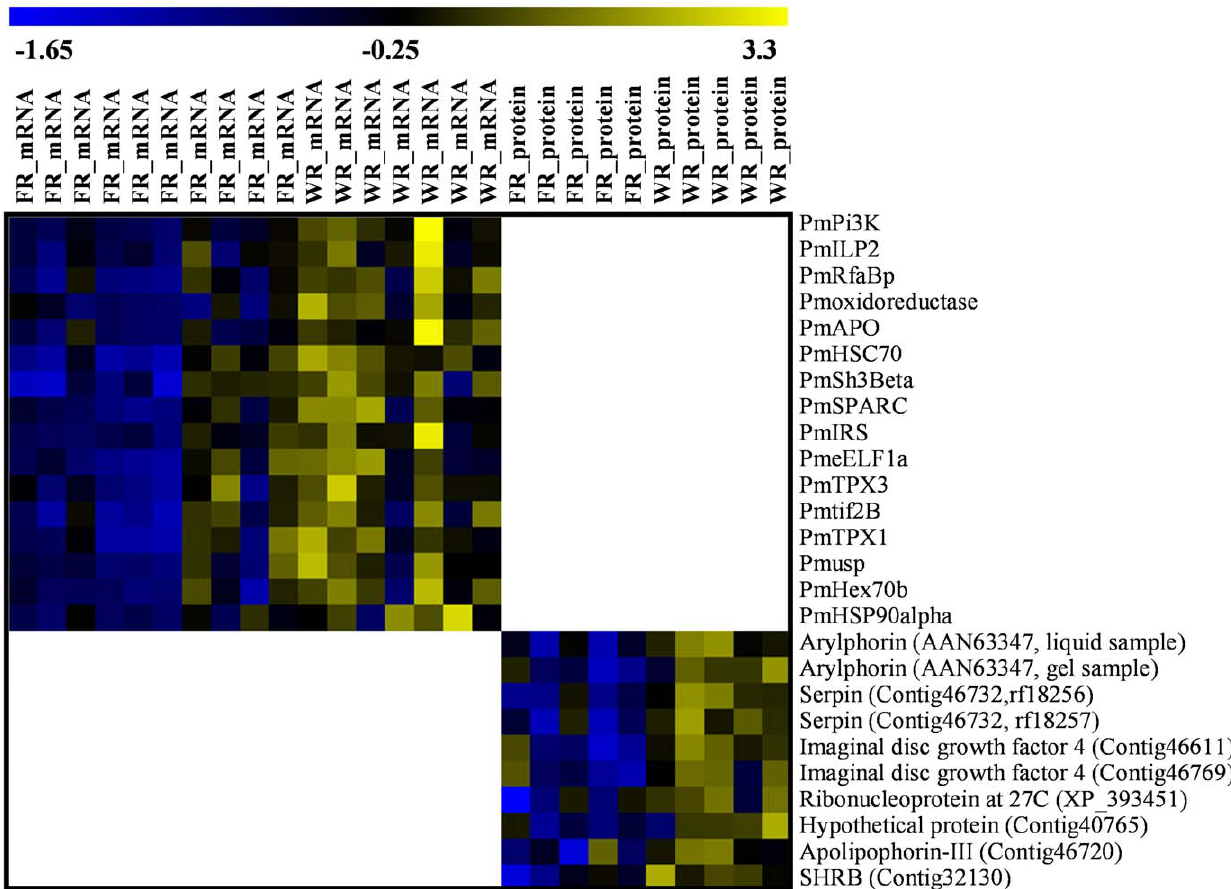
Figure 1. Heat map visualization of relative expression of sixteen genes and nine peptides. Sixteen genes (upper) and 9 peptides (lower) significantly differentially expressed in foundress-reared (FR; putative worker-destined) vs. worker-reared (WR; putative gyne-destined) P. metricus fifth-instar larvae. Bar at top gives color scale of relative expression from the mean expression: downregulation = blue; upregulation = yellow. Z- transformed transcript and peptide/protein abundances visualized using TMeV version 4.3.02.